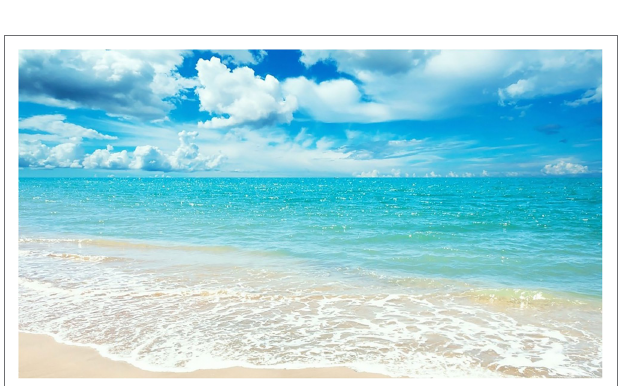
FIGURE 2 | The ocean image shown for 40 s between the baseline and post-intervention SARTs in Studies 1 and 2.